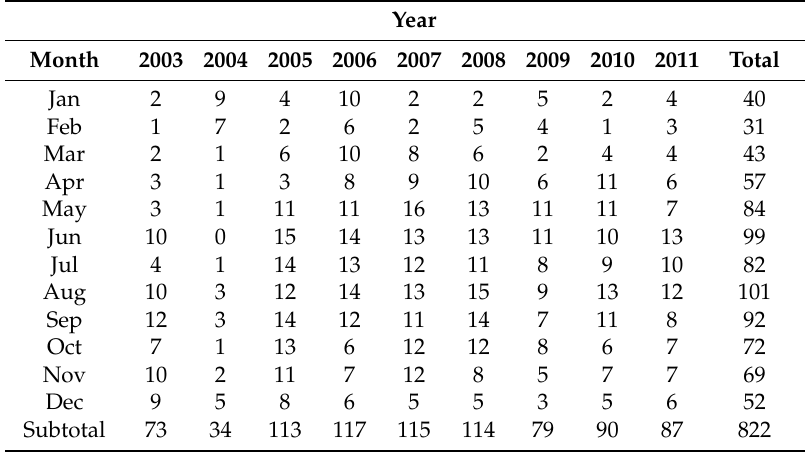
Table 1. Temporal availability of Medium Resolution Imaging Spectrometer (MERIS) images used in this study.